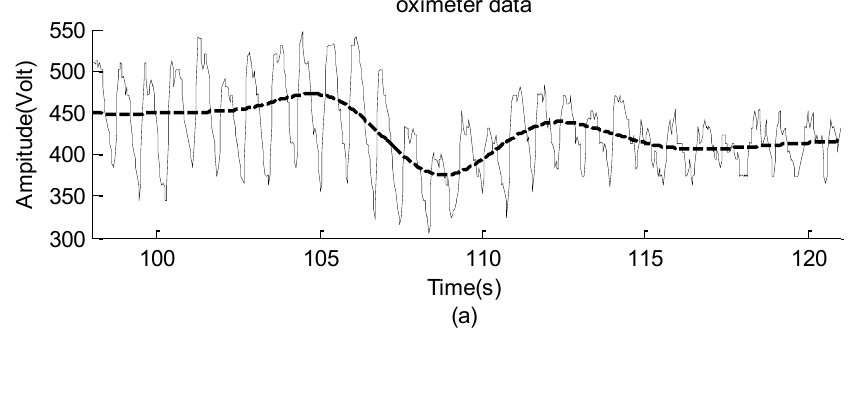
Figure 18. The raw data of the neck arterial pressure signal of an healthy adult: ( a ) the level of the blood-oxygen saturation captured by the pulse oximeter; and ( b ) captured by the high speed